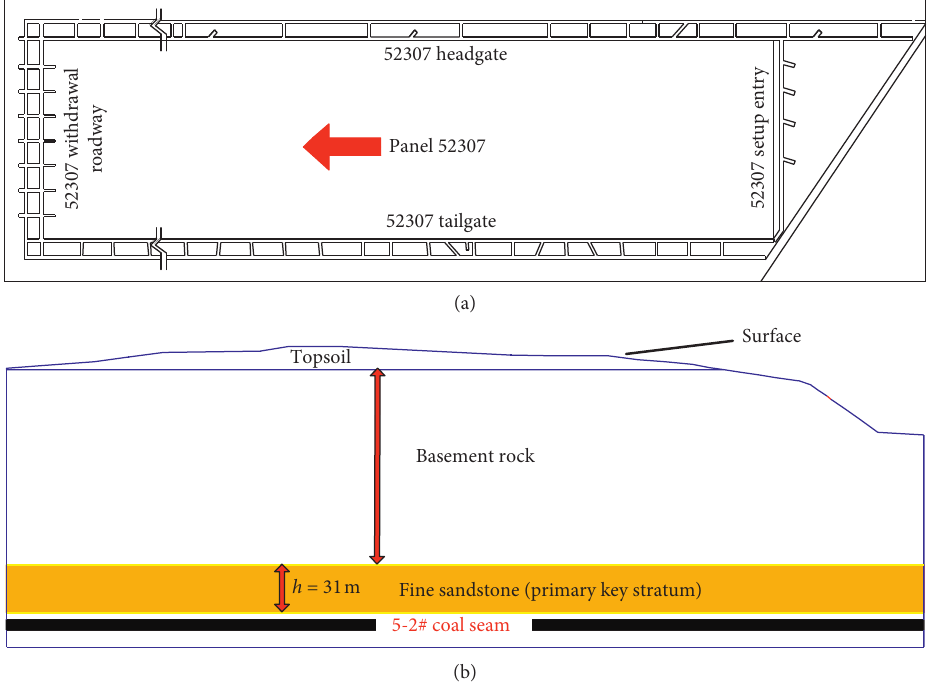
Figure 2: Roadway layout and overburden occurrence of working face 52307. (a) Roadway layout of working face 52307. (b) Overburden occurrence of the working face.